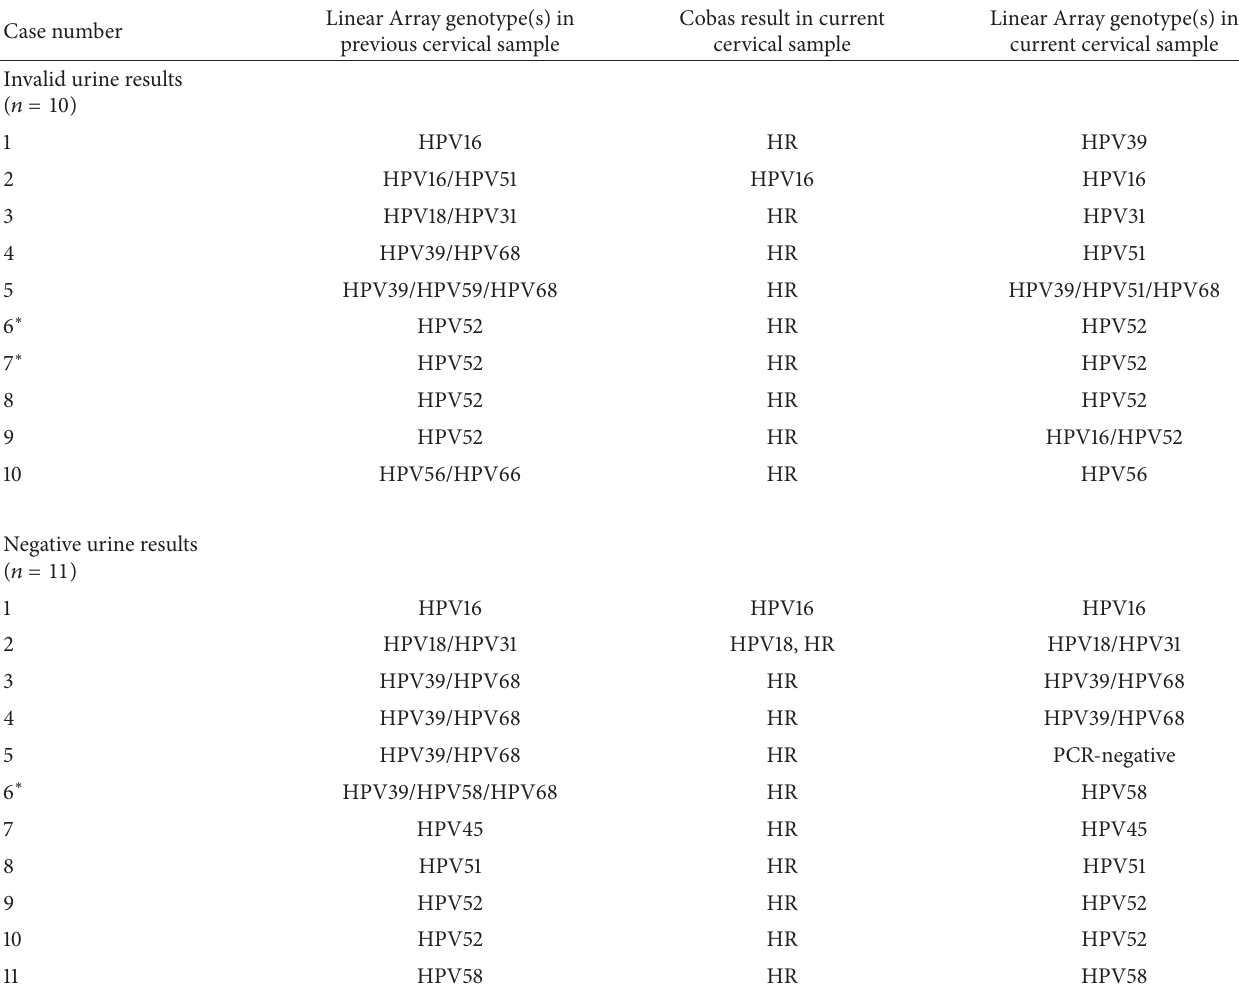
Table 3: High-risk HPV genotypes in women with Cobas-positive cervical samples but invalid/negative urine samples. Case